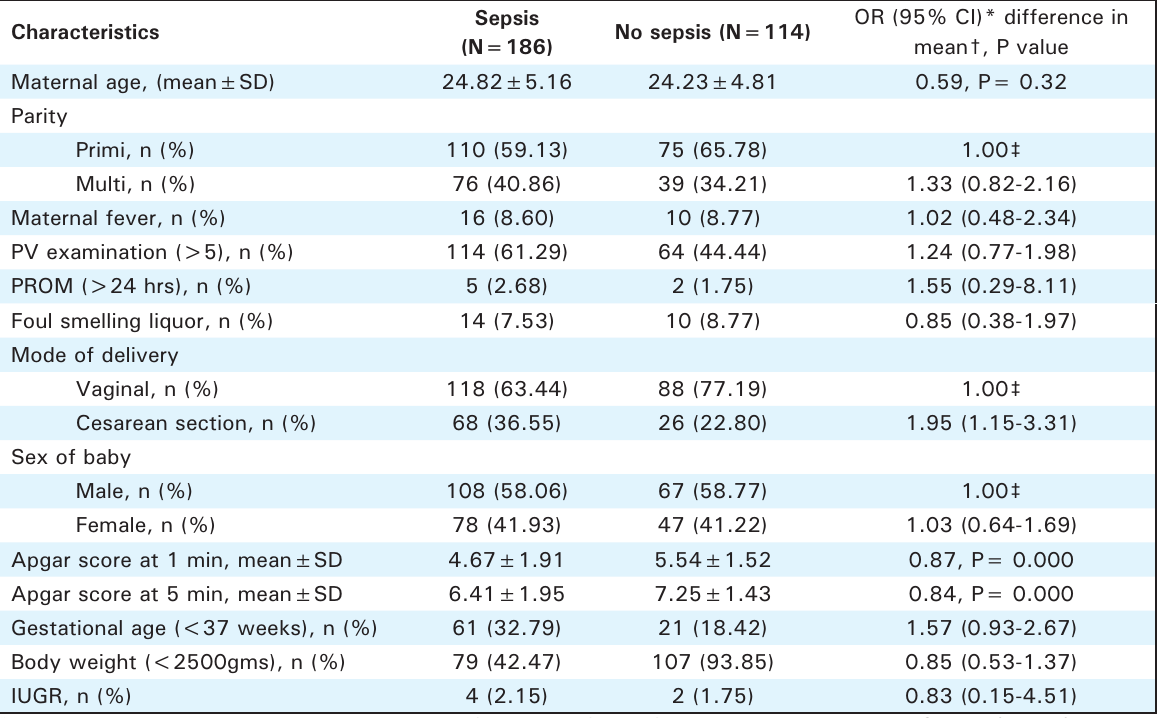
Table 1. Neonatal and maternal characteristics in relation to neonatal